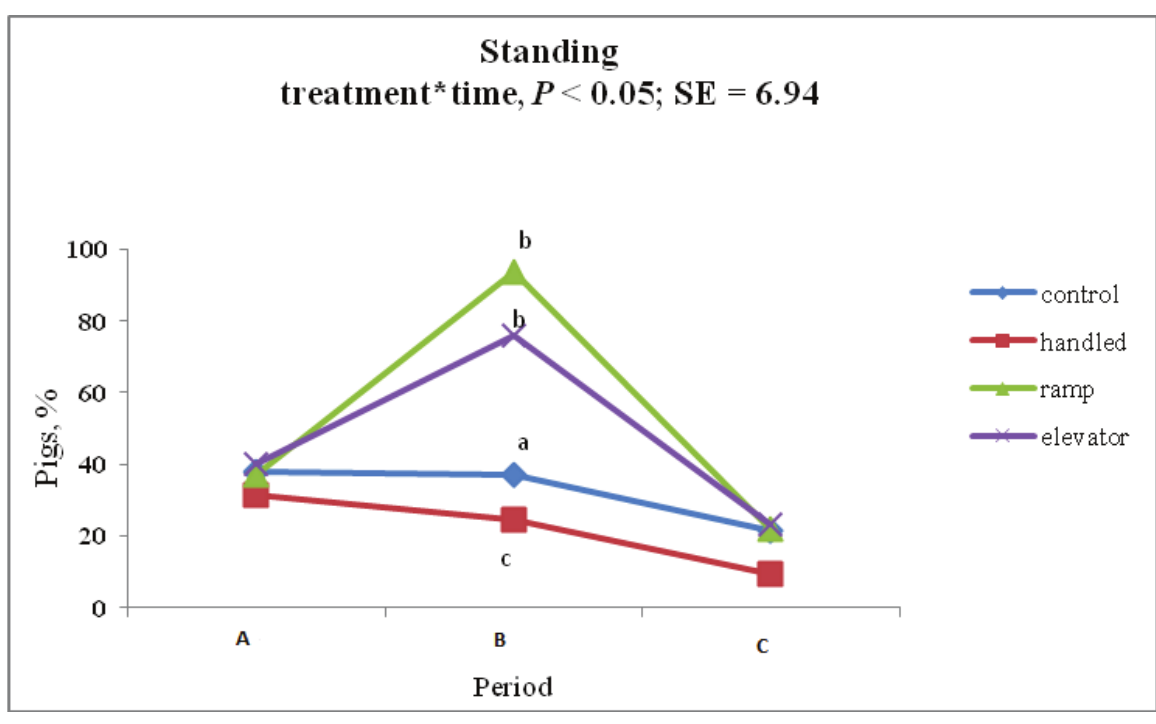
Figure 2. Percentage of pigs showing standing behavior an hour before (A), during (B) and after (C) each treatment (control, handling, ramp and elevator).